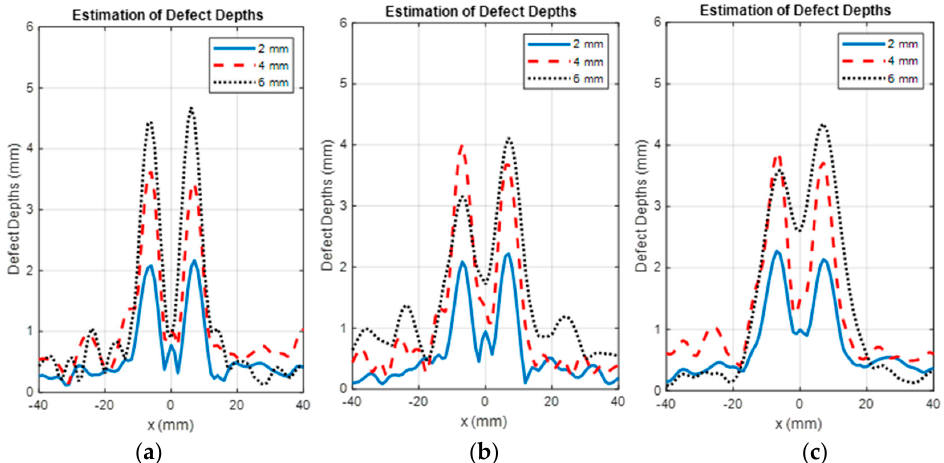
Figure 5. Thickness estimation of defects with H D of 2 mm, 4 mm, and 6 mm with ( a ) W D = 2 mm, ( b ) W D = 1 mm, and ( c ) W D = 3 mm.